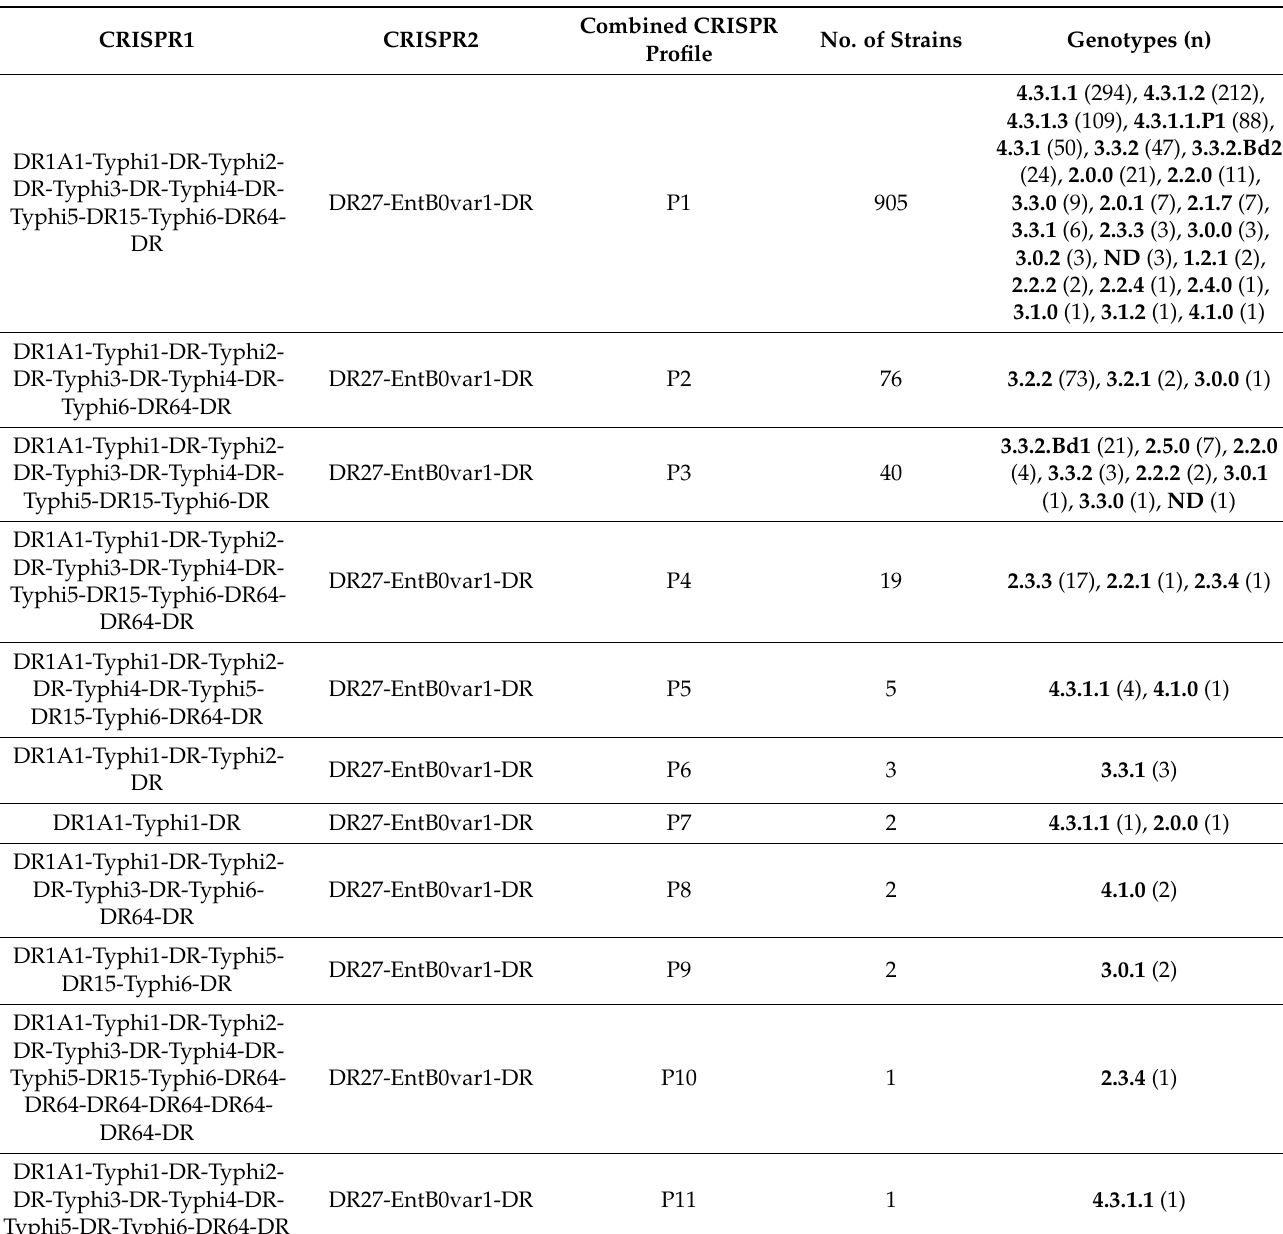
Table 1. CRISPR arrays, CRISPR profiles and genotypes of the 1059 S. enterica serovar Typhi genomes described by Tanmoy et al.